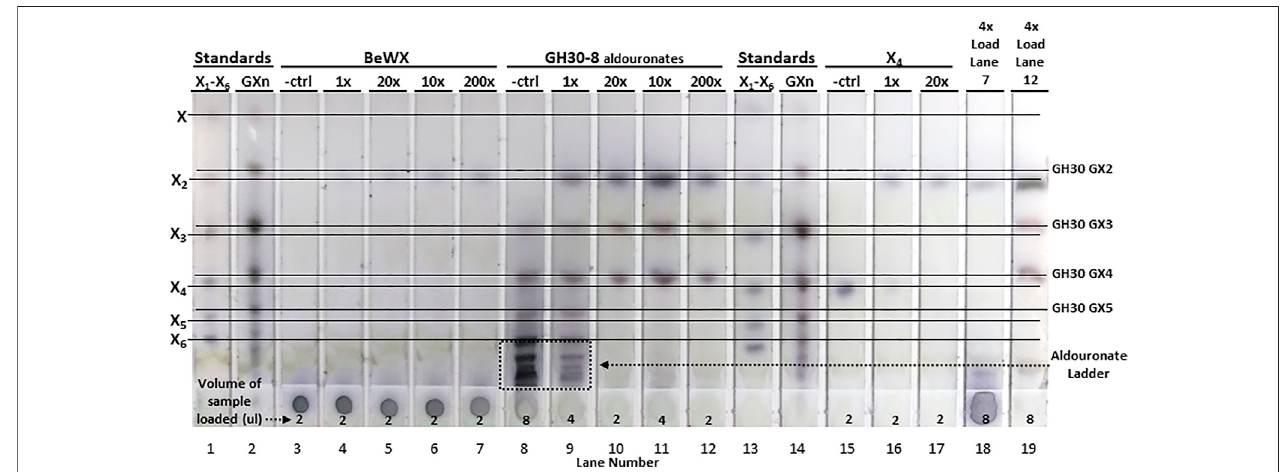
FIGURE 4 | TLC analysis showing hydrolysis products of Ac Xbh30A-CD GEP digestion of BeWX, an enriched GH30-8 aldouronate preparation and X 4 . Using a reaction concentration of Ac Xbh30A-CD GEP which empirically was determined to visually represent signi fi cant X 4 hydrolysis to X 2 (2 ug/ml for 15 min, 1x), enzyme concentration was increased 10-fold and reaction time increased to obtain 10x, 20x, and 200x increased relative enzyme capacity. In treatment of BeWX, only a light spot for X 2 was observed which reached approximately full intensity with the 10x enzyme condition. Complete conversion of the GH30-8 aldouronate was observed with the 10x enzyme level, and up to 200x treatment did not result in secondary activities detectable by TLC. As expected, Ac Xbh30A-CD GEP at 1x almost completely converted 5 mMX 4 toX 2 .Increasedloadvolumes (4x)ofthe200xenzymecapacityreactionsofBeWX andtheGH30aldouronate preparation did notreveal other hydrolysis